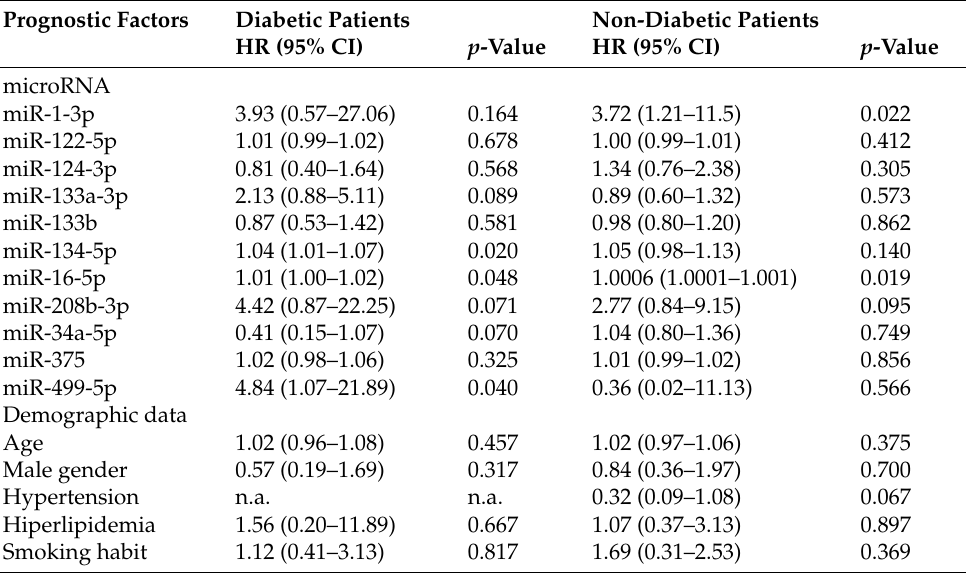
Table 2. Univariate Cox analysis for the incidence of major cardiac and cerebral events (MACCE) in diabetic and non-diabetic